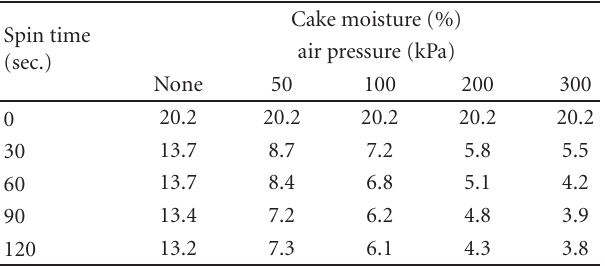
Table 2: E ff ects of G -force and air pressure on the dewatering of sphalerite sample ( − 150 μ m) at 1,000 G -force and 1.5cm cake thickness.